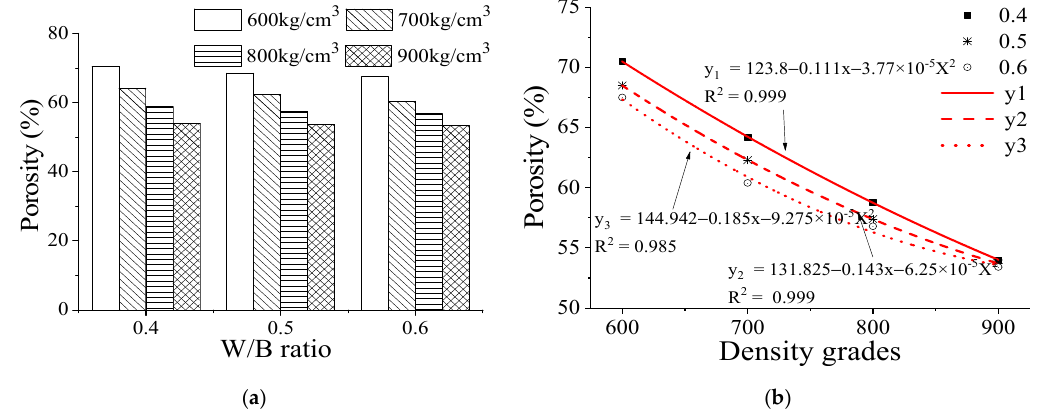
Figure 3. Effect of water-to-binder ratio on porosity of the foam backfill material at different density Figure 3. E ff ect of water-to-binder ratio on porosity of the foam backfill material at di ff erent density grades. ( a ) W/B ratio; ( b ) density grades. grades. ( a ) W / B ratio; ( b ) density